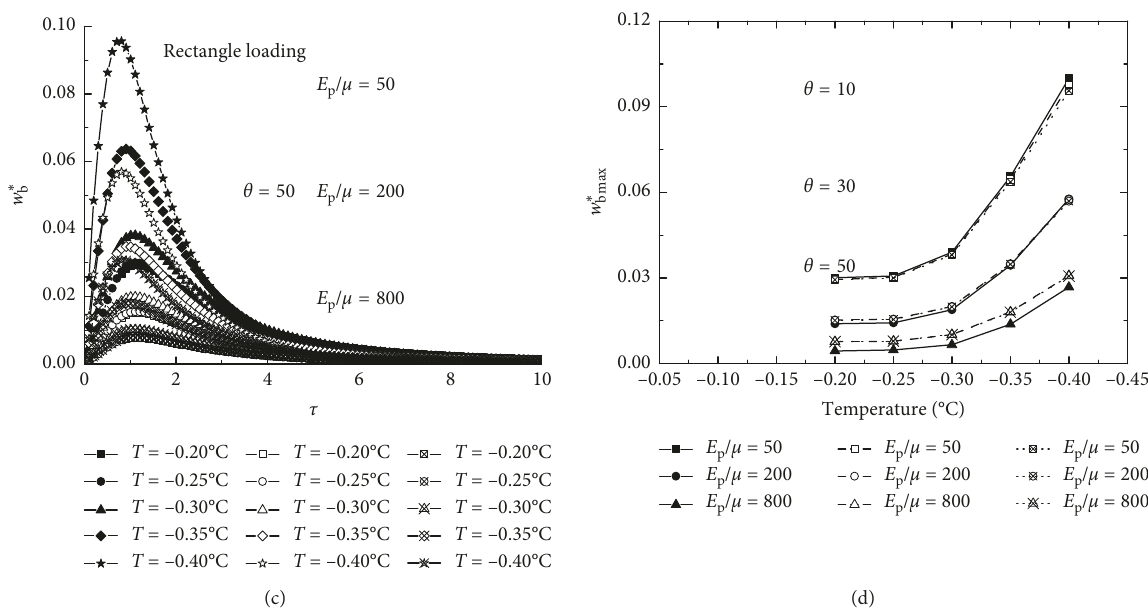
Figure 6: Effects of temperature on nondimensional axial displacement at pile head subjected to a rectangle loading pulse. (a) θ (b) θ 30. (c) θ 50. (d) Effect of temperature on maximum (cid:29) (cid:29)